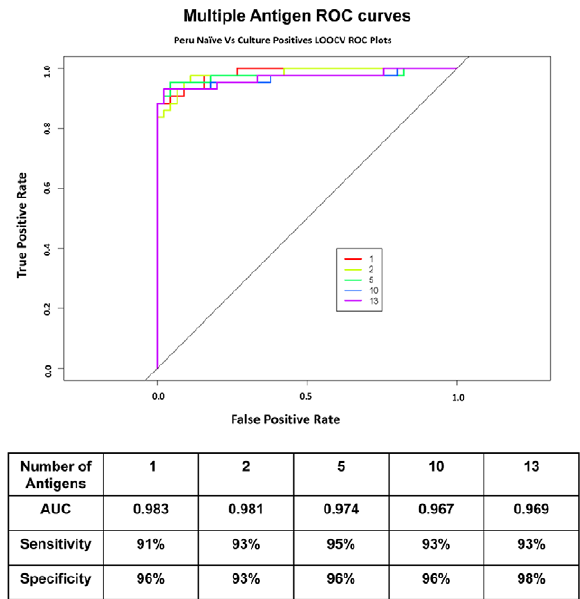
Figure 4. Multiple Antigen LOOCV ROC curves. The LOOCV ROC graphs show classifiers with increasing number of human serodiagnos- tic antigens. Overall, the sensitivity and specificity for array test is over